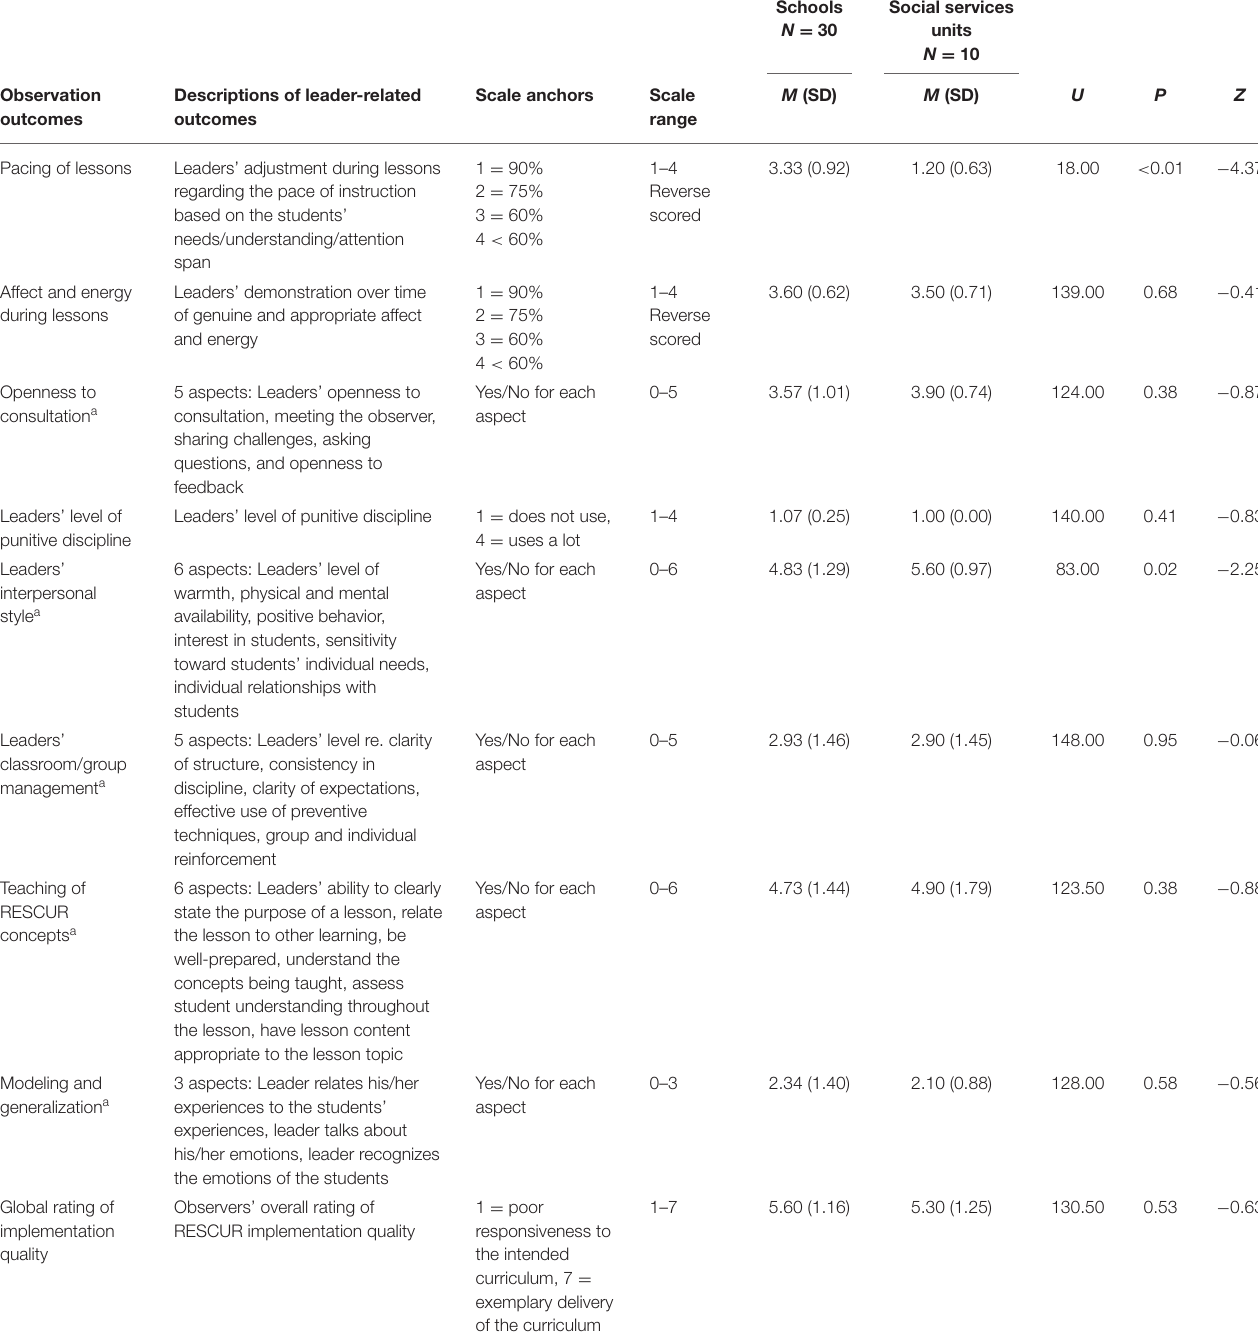
TABLE 2 | Observation protocol—implementation in schools and social services units after ∼ 3